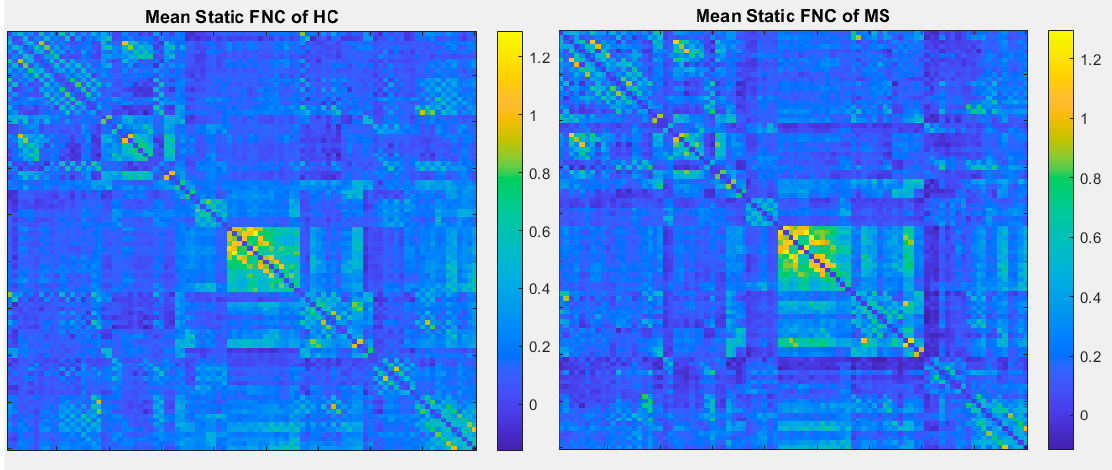
Figure 9. Mean static functional connectivity network for MS and HC using correlation with 90 brain regions defined by AAL